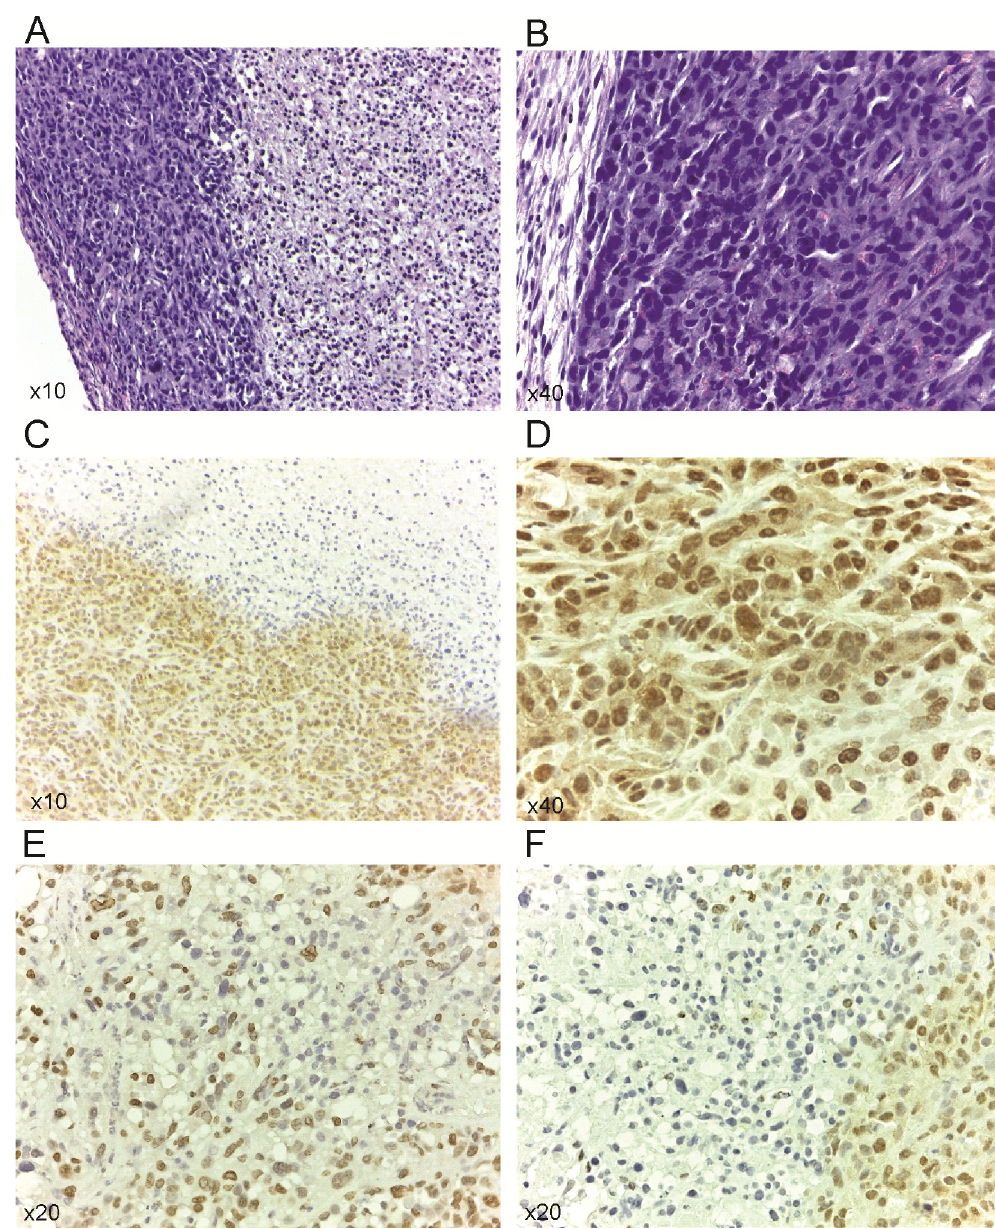
Fig 7. Expression of p-Met[Y1003] in control and in treated groups. (A) Tumor section showing peripheral areas with preserved morphology and vast areas of central necrosis. H&E stain. (B) The tumor cells show high pleomorphism, hyperchromasia and increased mitotic activity. H&E stain (C) Immunohistochemistry for p-Met[Y1003]. Untreated controls demonstrate uniform intense immunopositivity in the peripheral vital areas of the tumor (lower left). The necrotic central parts of the tumor are immunonegative (upper right). (D) Untreated controls reveal intense immunopositivity in both nuclear and cytoplasmic distribution. (E, F) UFT+CTX treatment group shows significantly decreased staining intensity with only focal immunopositivity p-Met[Y1003] in a predominantly nuclear pattern. Vast areas of viable tumour are not staining